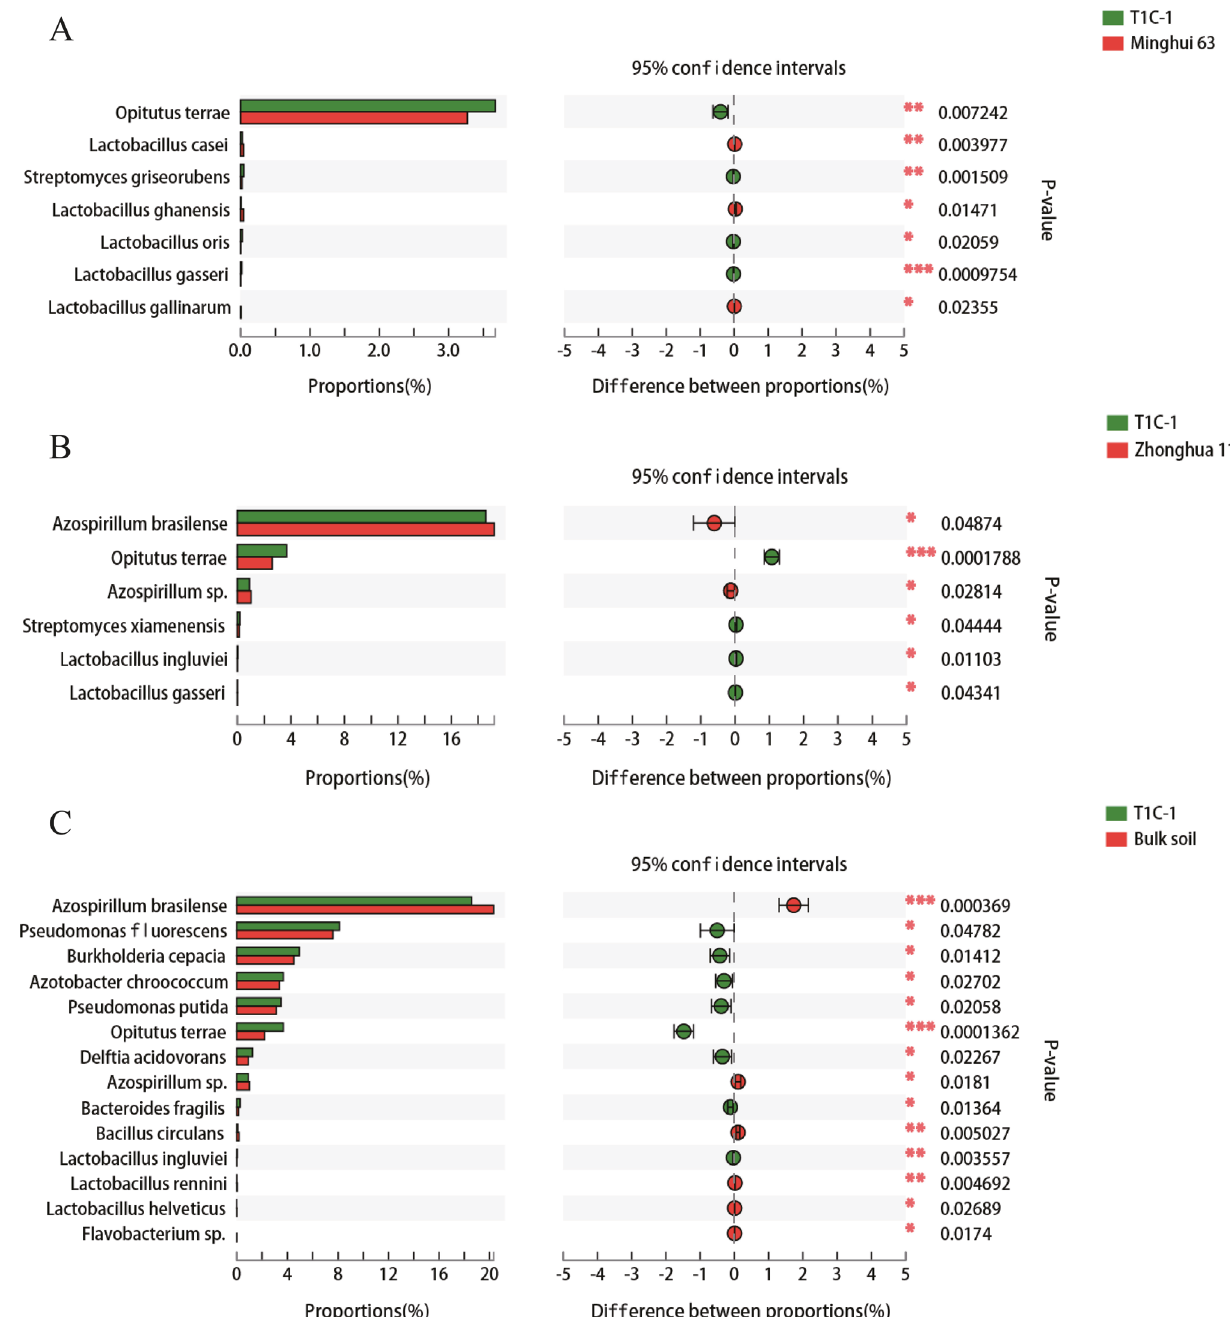
Fig. 3 Differentially abundant probiotic microorganisms between paired sample